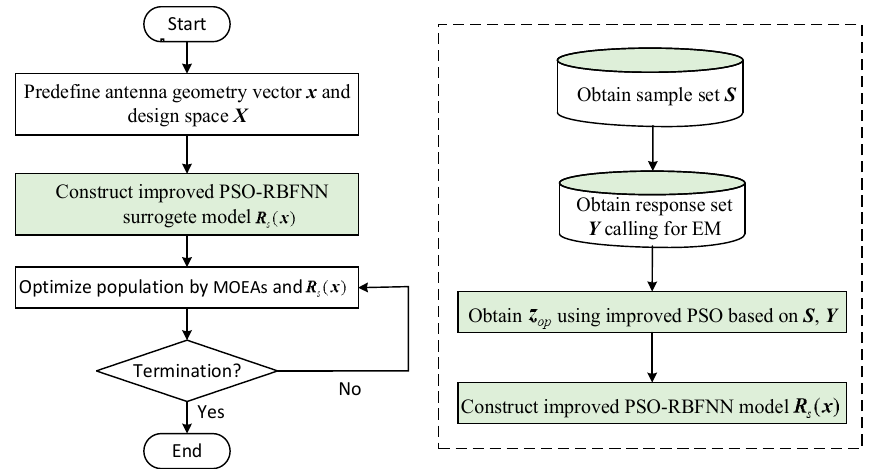
Figure 7. Flowchart of fast multi-objective antenna optimization framework based on multi-objective evolutionary algorithms (MOEAs) and improved PSO-RBFNN surrogate model.